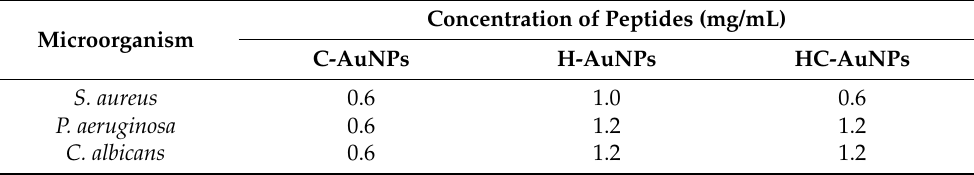
Table 5. Concentration of peptides that was able to cause the inhibition of microbial